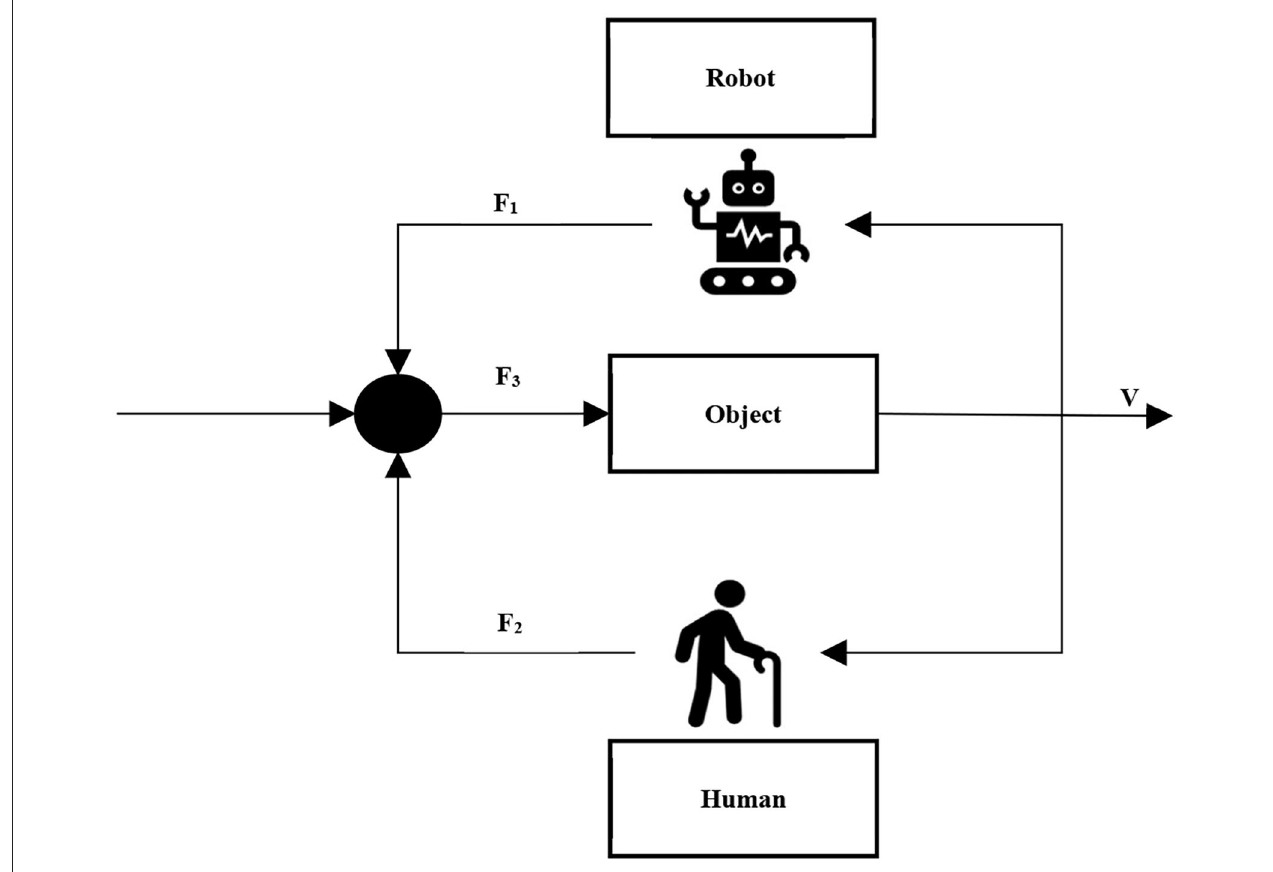
FIGURE 2 | Human–machine coordinated motion model.